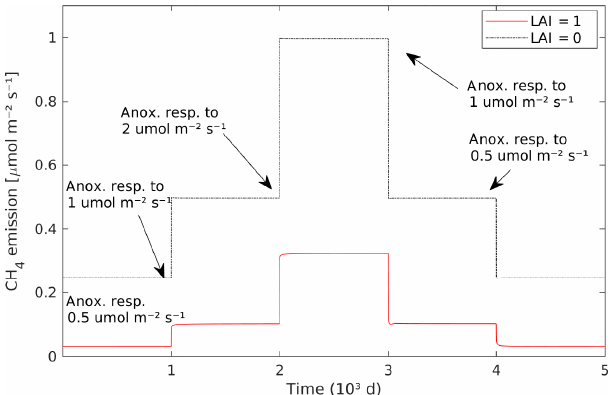
Figure 7. Relationship between the relative CH 4 emission rate (ex- pressed as percentage of PMP) and different combinations of in- put (a) temperature, (b) WTD, and (c) LAI in the steady-state sensi- tivity tests with constant anoxic respiration (test names ending with _R1).